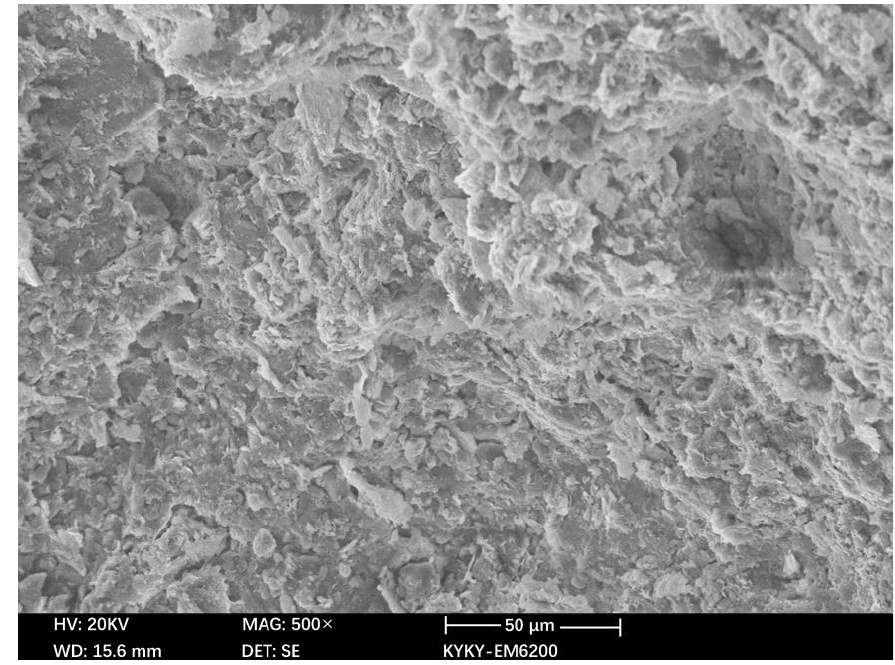
Figure 8. SEM microstructure of soil samples before MICP treatment.